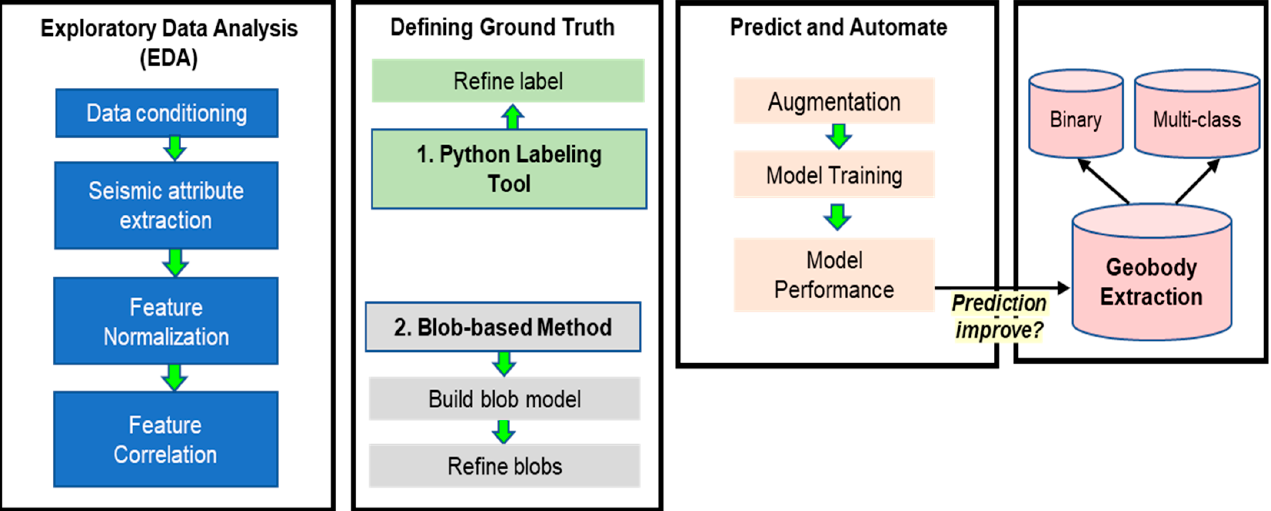
Figure 3. Integrated methodology applied in this study consists of four main steps: 1. Exploratory Data Analysis (EDA) for input data; 2. Define the ground truth based on two scenarios; 3. Train the dataset and monitor the model’s performance; 4. Geobody extraction to be integrated with another relevant dataset.